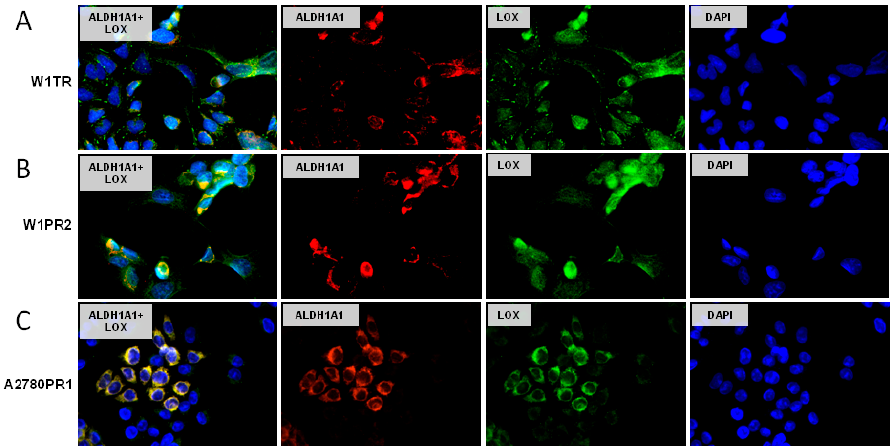
Figure 8. Immunofluorescence visualization of LOX and ALDH1A1 coexpression in the W1TR ( A ), W1PR2 ( B ), and A2780PR1 ( C ) cell lines. LOX was detected using the anti-LOX antibody and Alexa Fluor ® 488-conjugated secondary antibody (green). ALDH1A1 was detected using the anti-ALDH1A1 antibody and Alexa Fluor ® 594-conjugated secondary antibody (red). To visualize the cell nuclei, the cells were mounted with a DAPI-containing mounting medium (blue). Objective 40×.